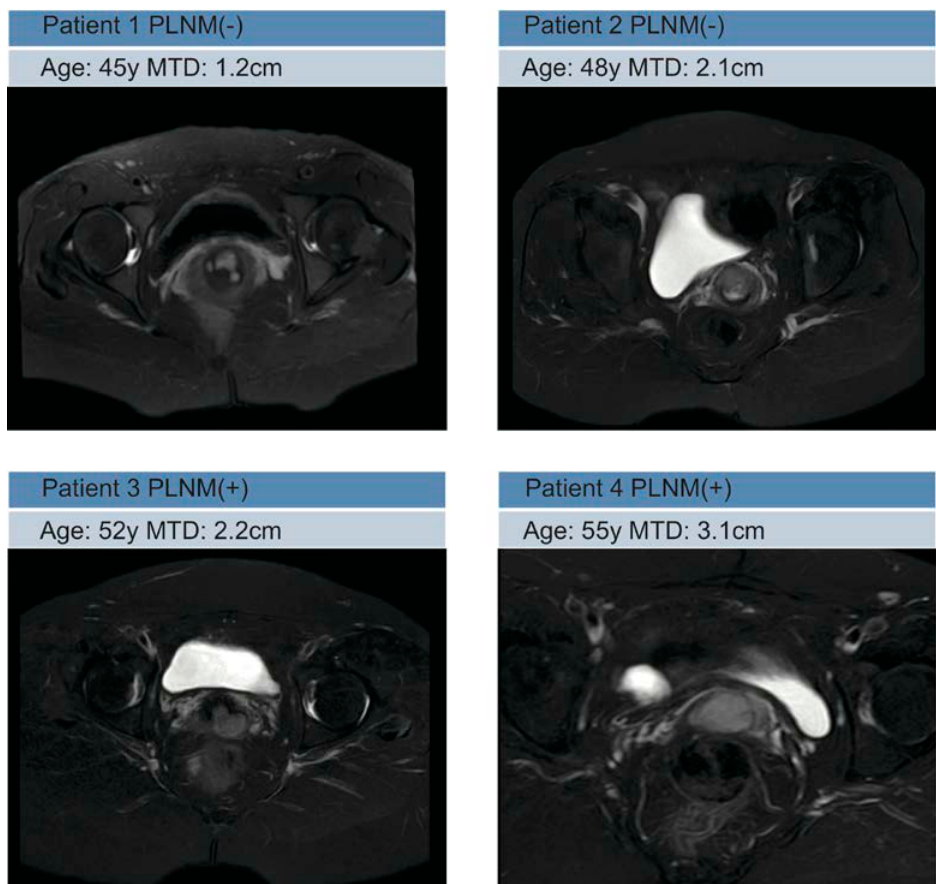
Figure 2. Representative MRI images in PLMN( − ) and PLMN(+) patients.